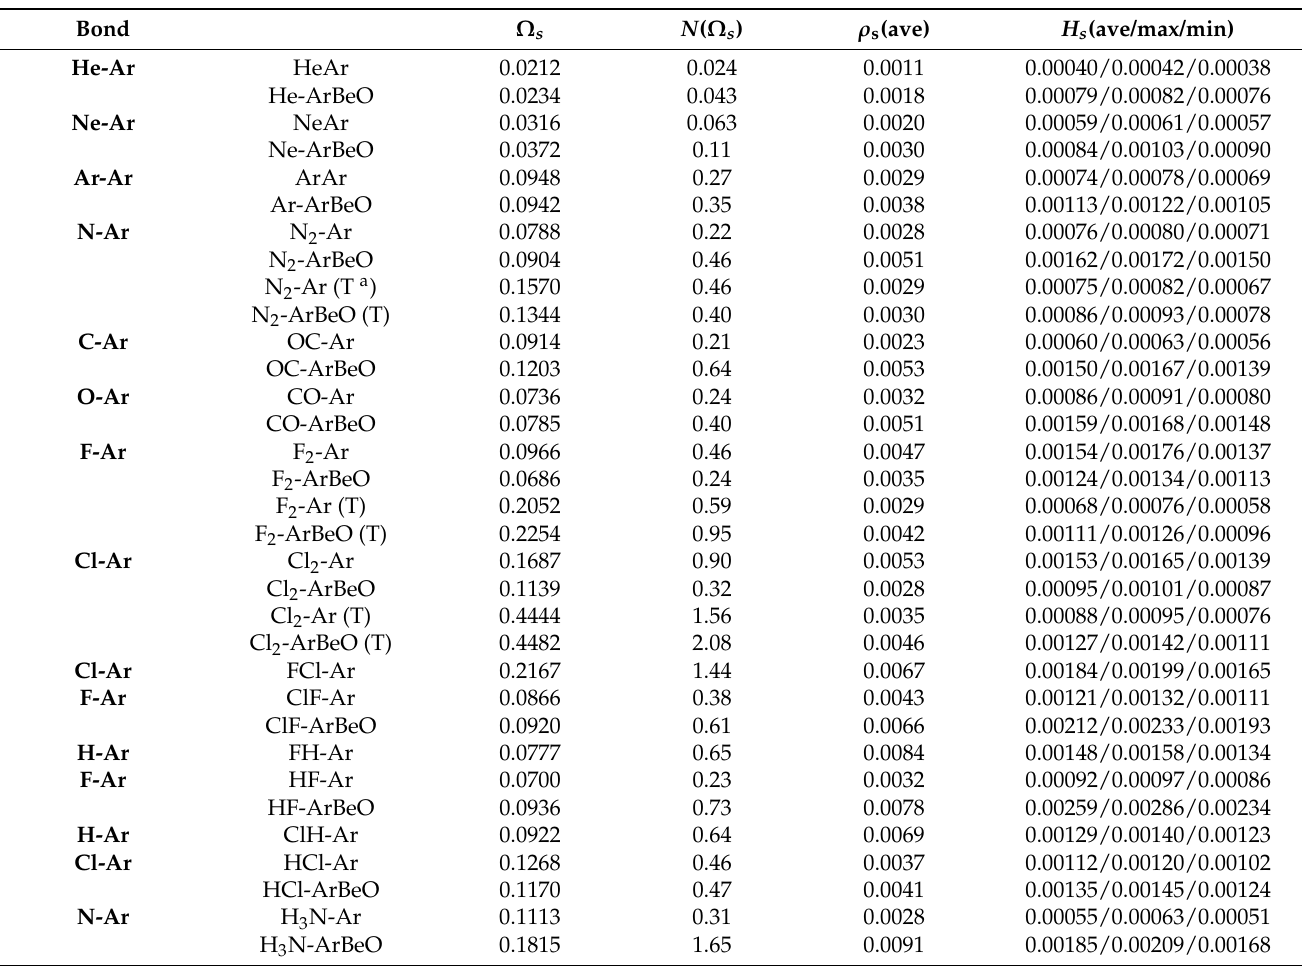
Table 2. MP2/aVTZ properties of the nCov(C) bonds (see text) of the L Ar and L -ArBeO (see Figure 2). N ( Ω s ), ρ s (ave), and H s (ave/max/min) are, respectively, the total electronic charge (m e ), the average electron density ( e a 0 − 3 ), and the average, maximum, and minimum of H ( r ) (hartree a 0 − 3 ) over the volume Ω s ( a 03 ) enclosed by the s ( r ) = 0.4 isosurfaceat around the